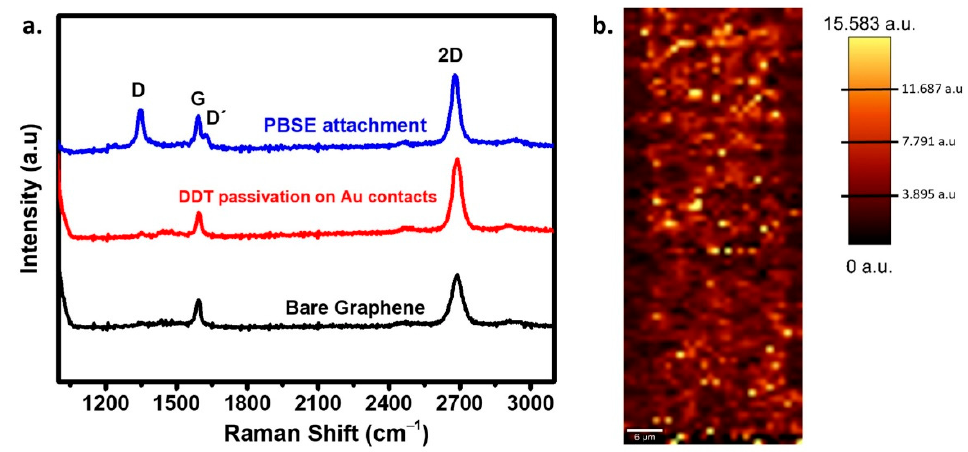
Figure 2. ( a ) Raman spectra of bare and modified graphene channel, ( b ) the corresponding 2D/G Raman intensity ratio maps of the single-layer graphene